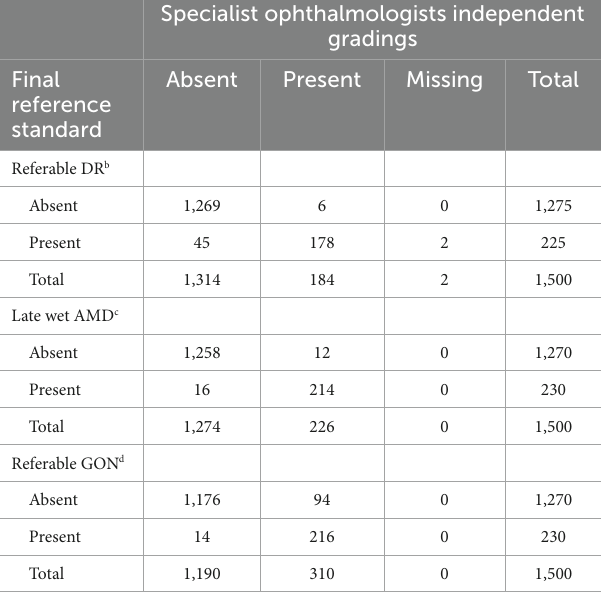
TABLE 1 Comparison of the five specialist ophthalmologist’s independent gradings vs. final expert consensus reference standard for 300 fundus photographs. a